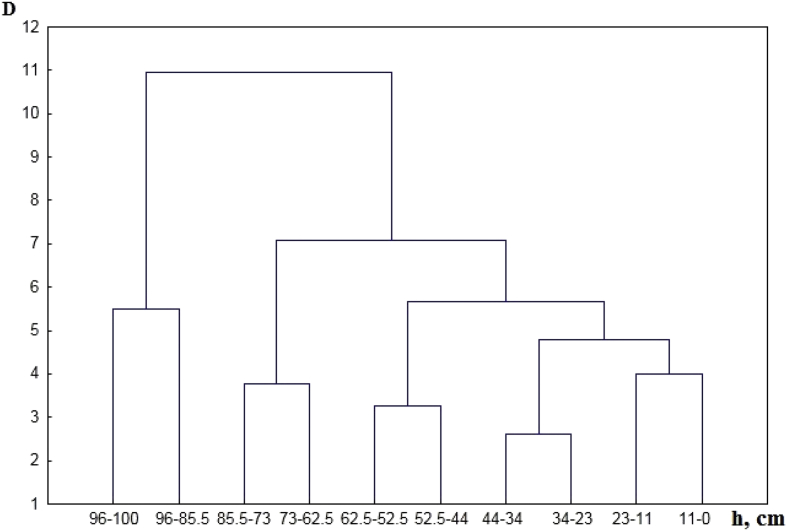
The results of a cluster analysis based on the concentration of chemical elements and oxides that were used to calculate geochemical coefficients (SiO2, Al2O3, CaO, MgO, P2O5, K2O, MnO, Cu, Na, TiO2, Sr, Ba, Rb) in the layers of pedosediments (2019).